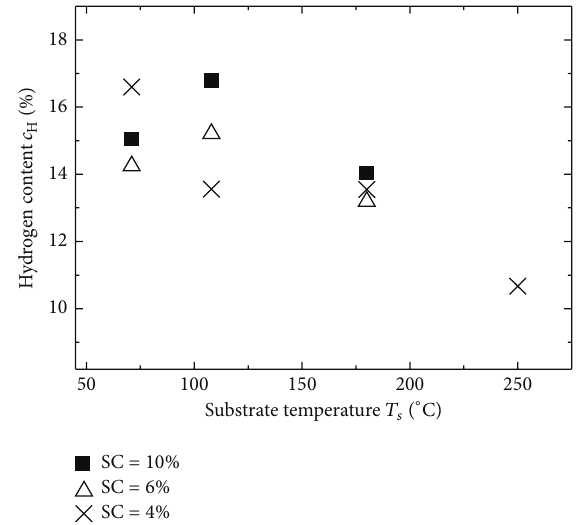
Figure 2: Hydrogen content as a function of the substrate temper- ature during deposition of the a-Si:H layers, with different silane concentrations.